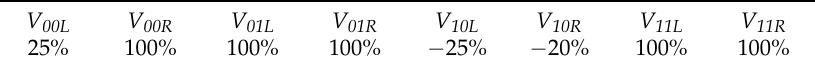
Figure 5. Generality of the 32 evolved best-of-run behaviors of the team of predator agents. Table 4. Velocity mappings of the most prominent behavior #17. The sensor offset is 20°.